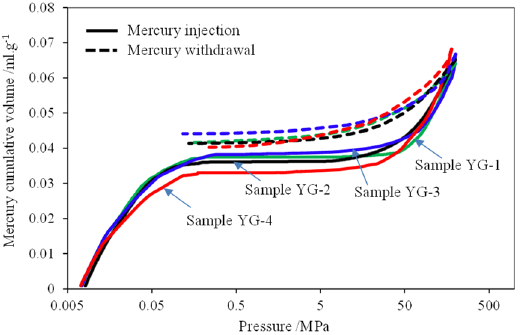
Figure 3. Mercury intrusion–extrusion data. The green line is the result of sample YG-1, the black is the result of sample YG-2, the blue is the result of sample YG-3, and the red line is the result of sample YG-4. Table 2. Fracture porosities of coal samples drilled at different depths in the Hunchun coalfield. Drill Hole No.